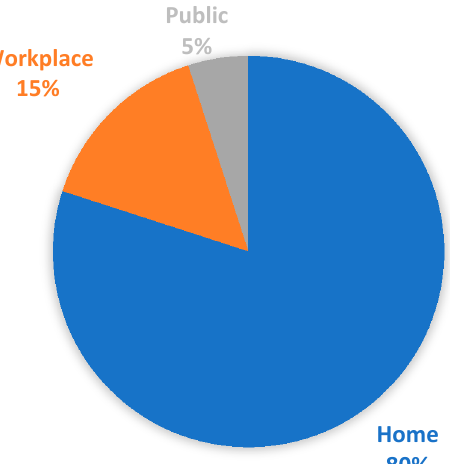
Figure 4. Percentage of each charging behaviour.